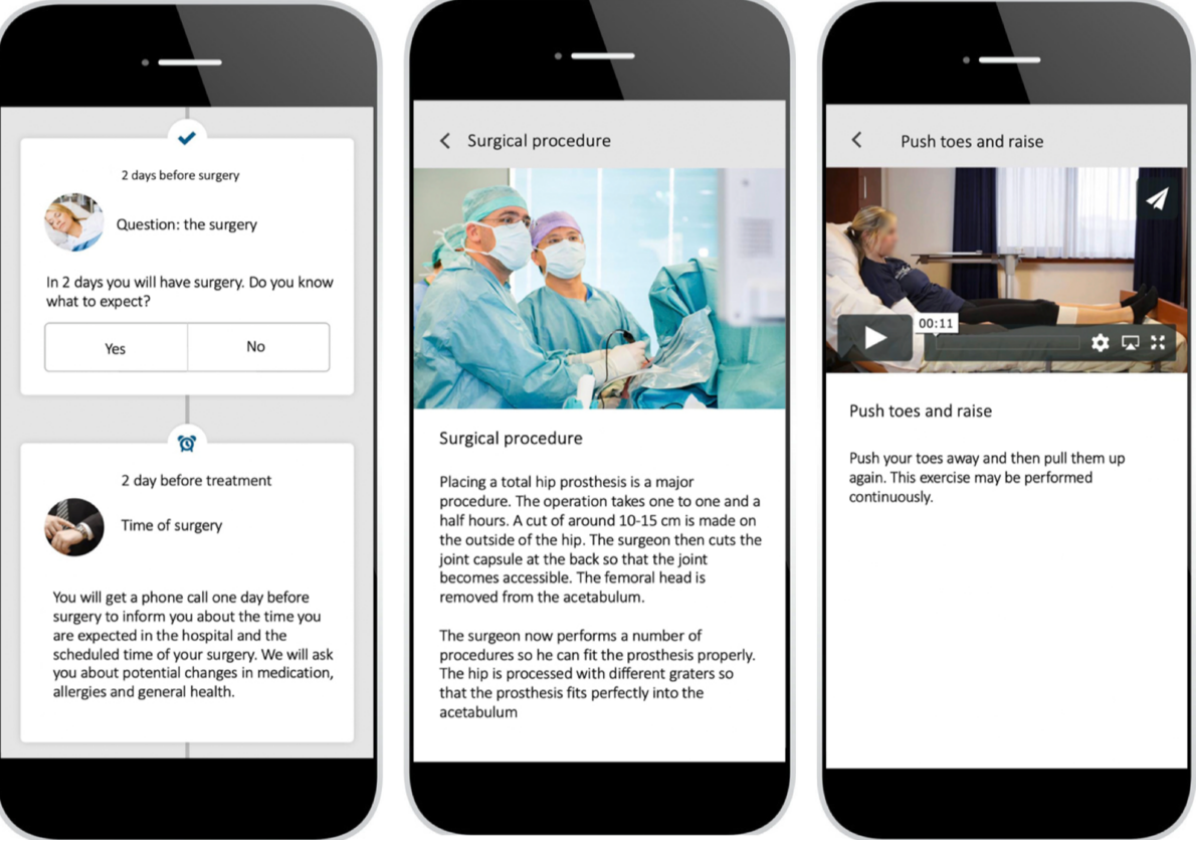
Figure 1. Patient Journey user